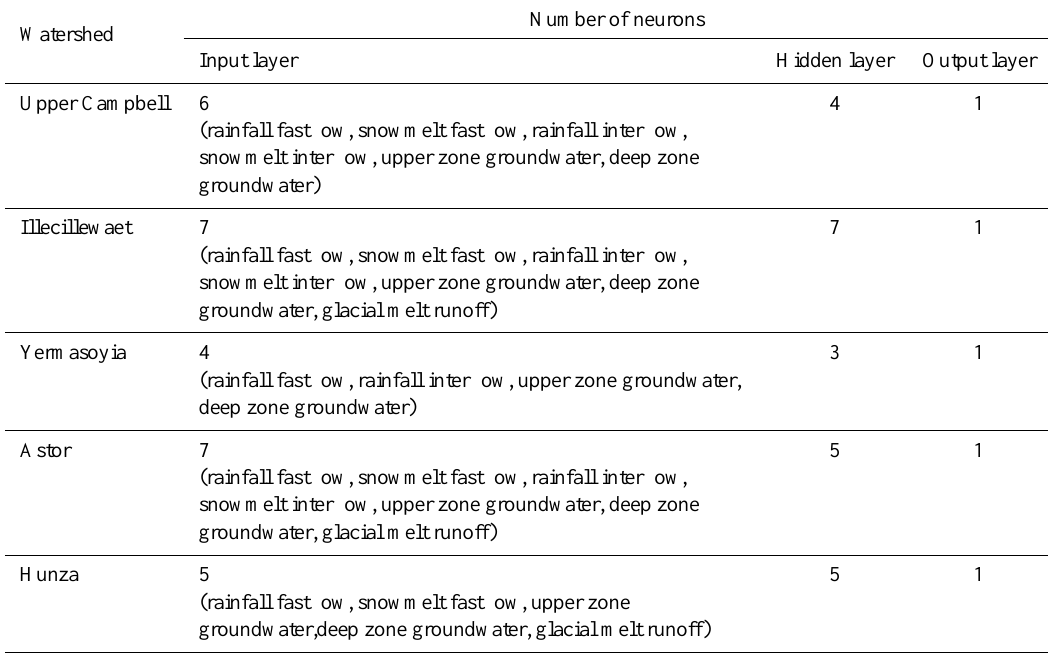
Table 5. Geometry of optimized ANNs used in the methodology for poorly gauged watersheds. Watershed